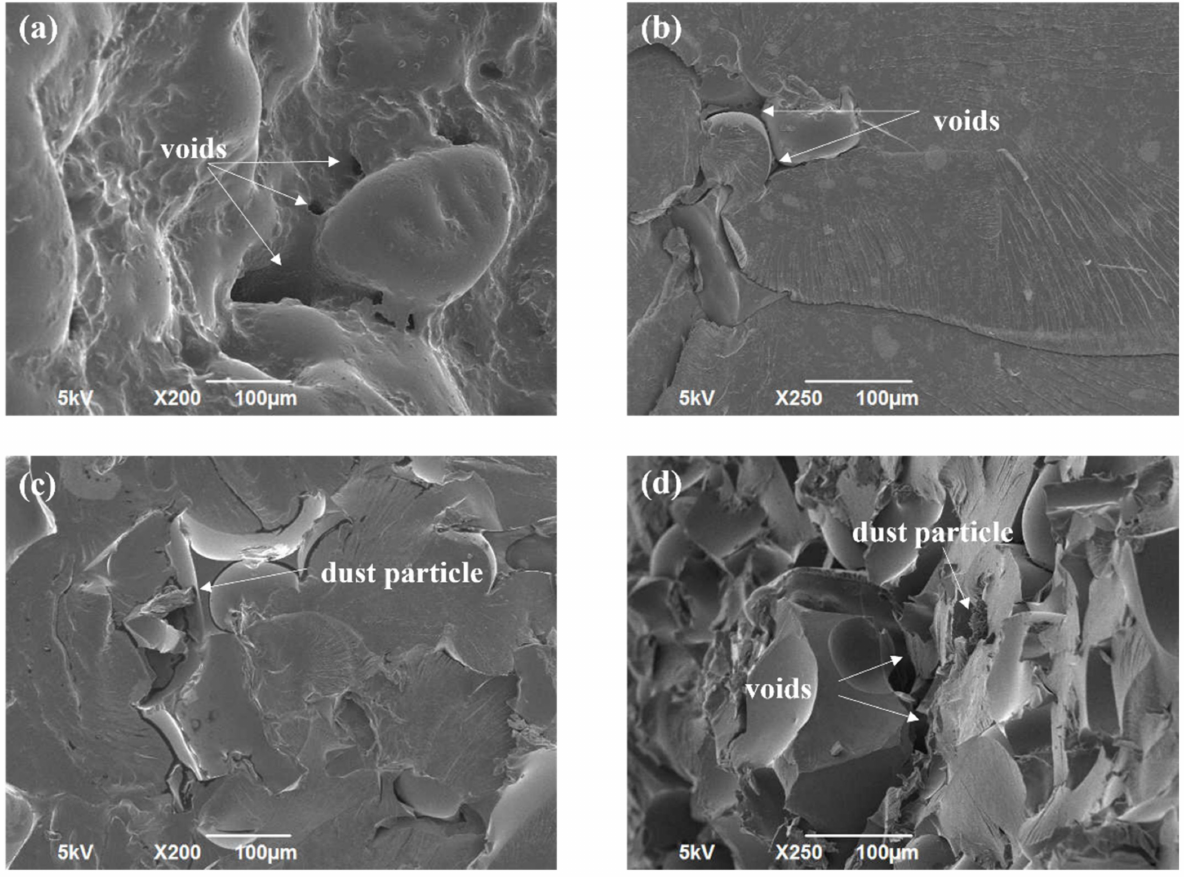
Figure 2. SEM images of ( a ) pure polyester, ( b ) 10-PUD, ( c ) 30-PUD ( d ) and 50-PUD